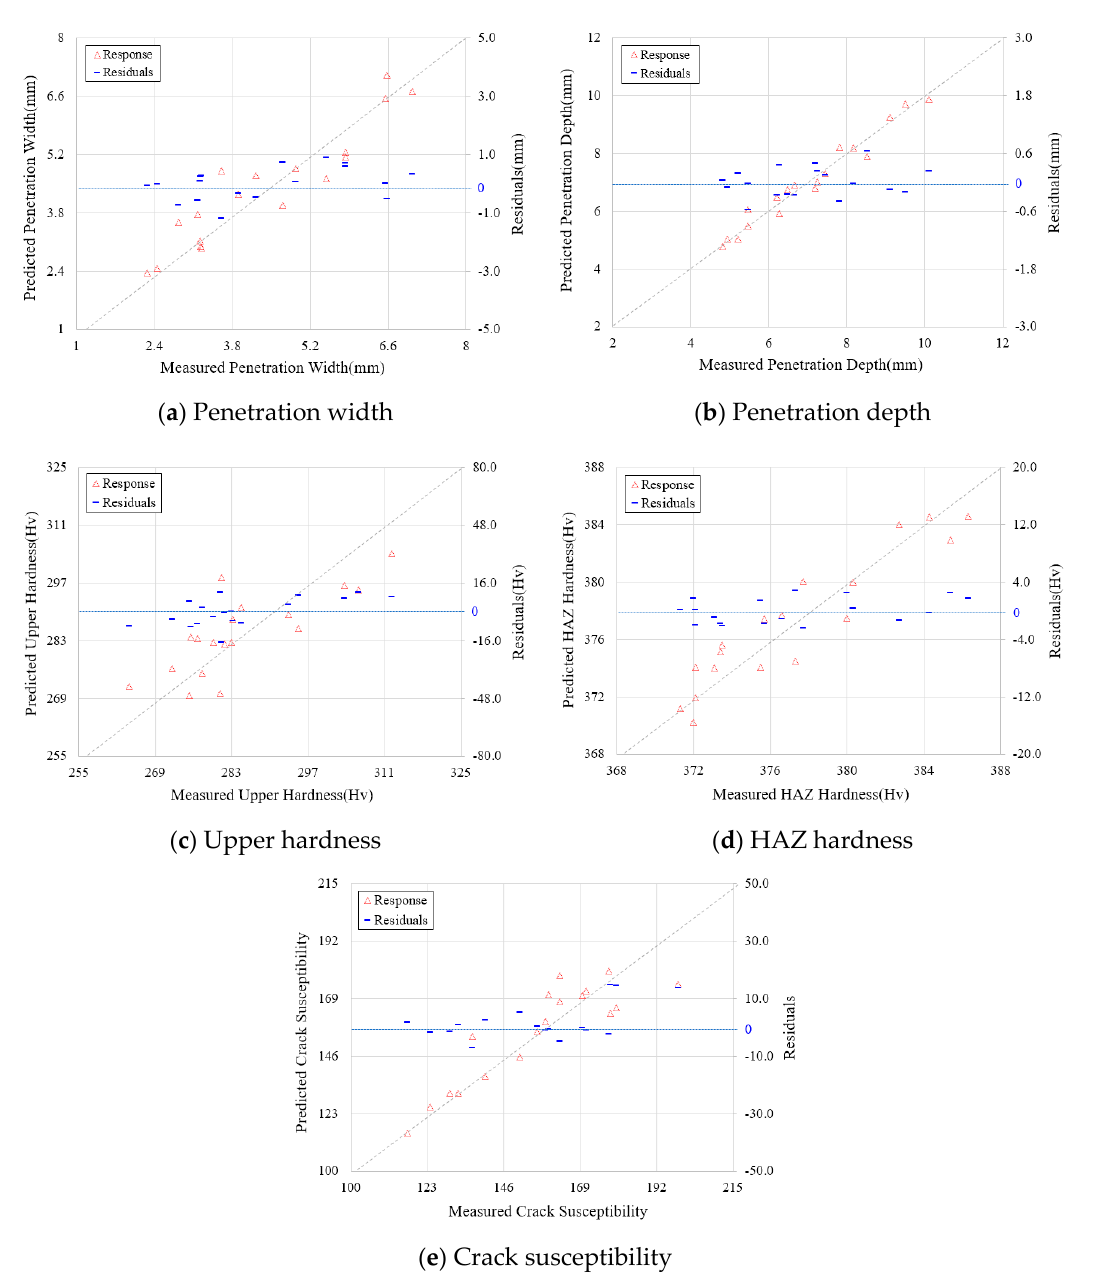
Figure 10. Comparison between measured and predicted welding factors according to mathematical model: ( a ) Penetration width, ( b ) Penetration depth, ( c ) Upper hardness, ( d ) HAZ hardness and ( e ) Crack susceptibility. Table 11. Analysis variance tests for predicted model for welding factors.